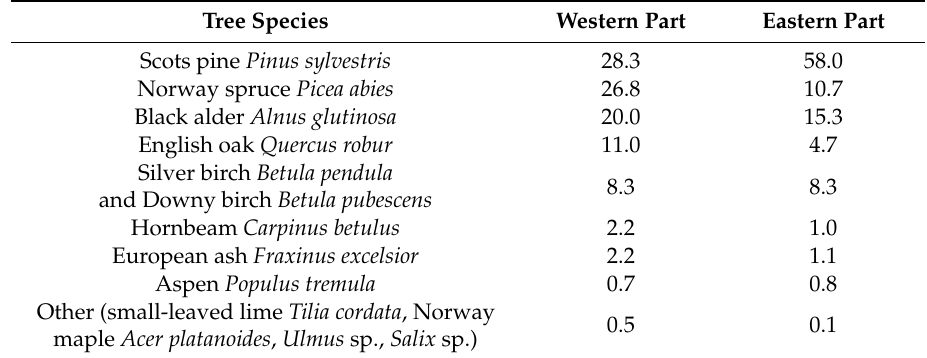
Table 2. Share (%) of the main tree species (according to tree species prevailing in the stand) in Białowie˙za Forest in the western (Polish—as of 2001) and eastern (Belarussian—as of 2005) part. Source of data: